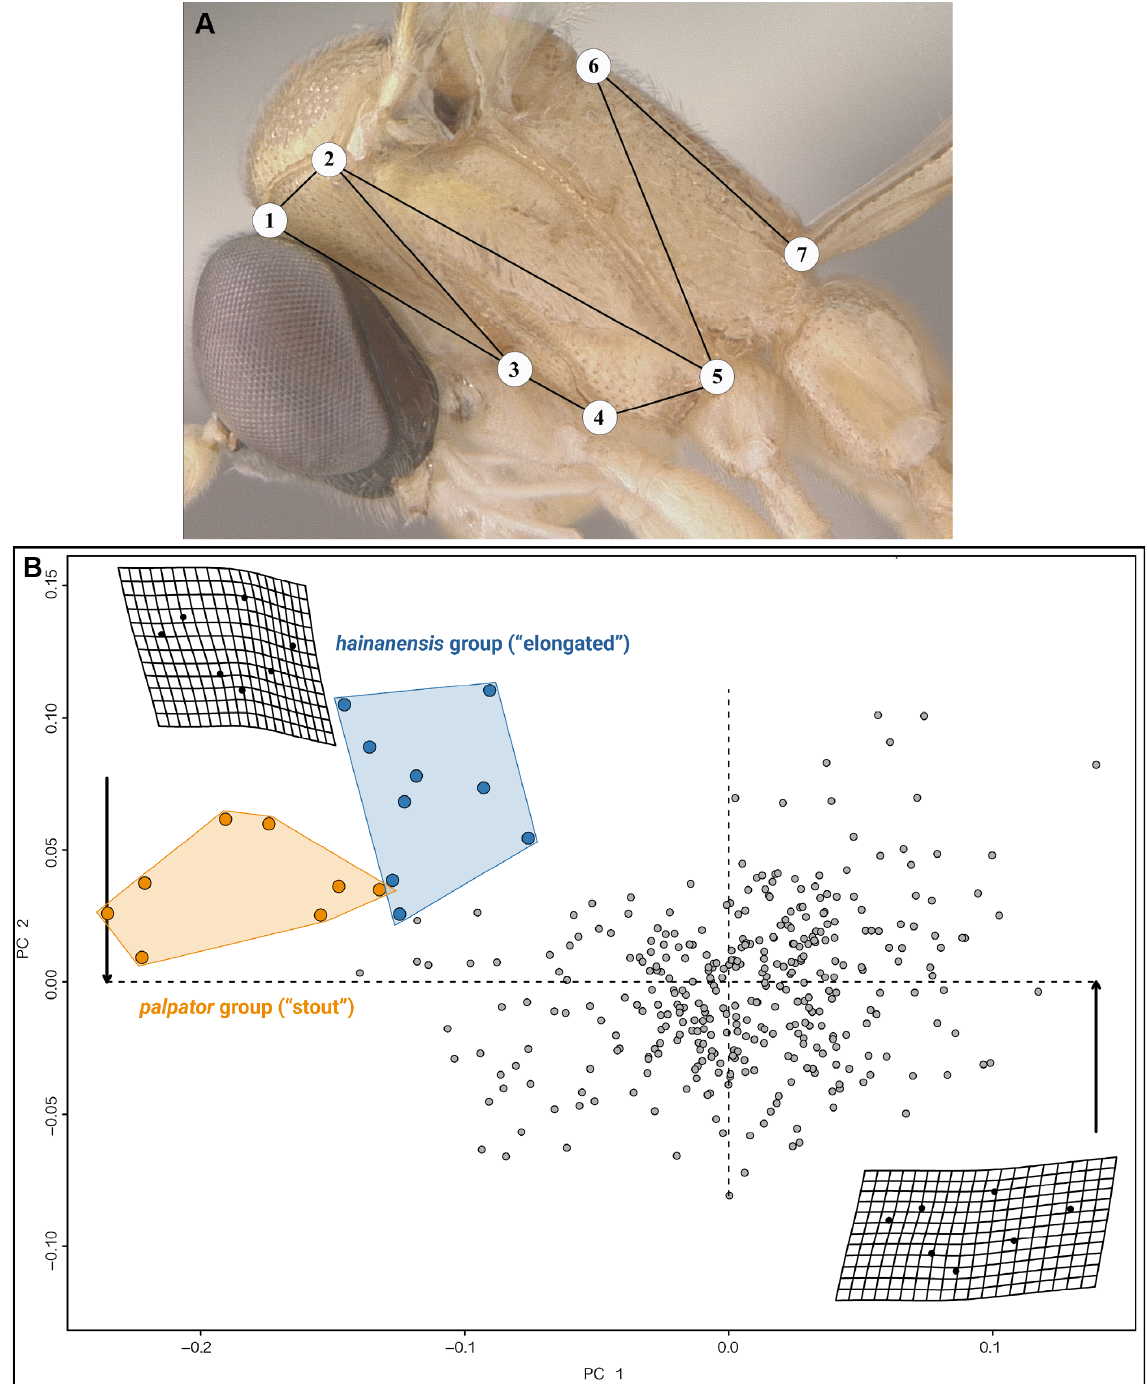
Fig. 4. Morphometrics. A . Landmarks used for the geometric morphometric analyses, following Santos et al. 2019. B . Two principal components (PC1 and PC2) of the shape space for the mesosoma, plotted over a Procrustes-aligned tangent space. Gray dots represent the general ichneumonid morphospace as represented by 347 species from eleven subfamilies. Orange dots and polygon delimit the morphospace occupied by species of the palpator group, and blue dots and polygon represent species of the hainanensis group. Objects at each extremity of the X-axis are deformation grids representing the mean shapes at the extreme of the first principal